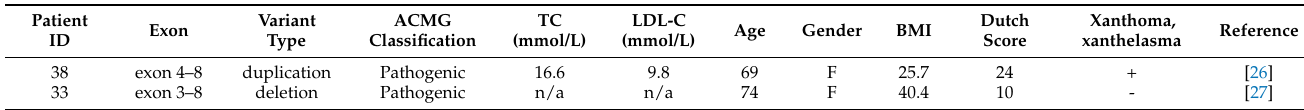
Table 4. Clinical and phenotypic data in Hungarian patients with LDLR variants and detailed summary of LDLR variants—patients with LDLR